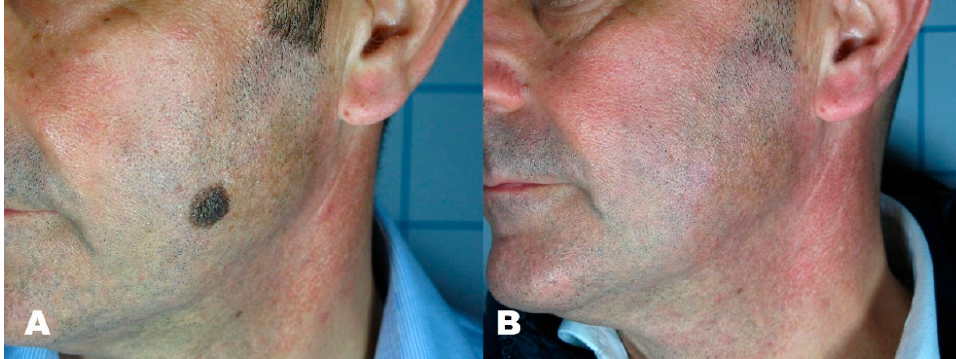
3 of 11 Figure 3. ( A ) Sebaceous hyperplasia before treatment. ( B ) Region after removal with Erbium laser. Figure 4. ( A ) Xhantelasmas before treatment. ( B ) Region after removal with Erbium laser.